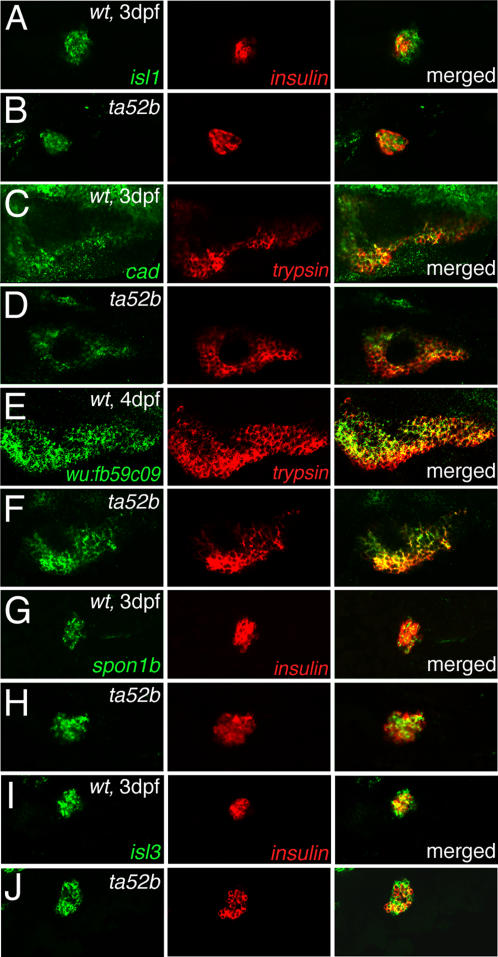
Validation of expression profile of differentially expressed genes with fluorescent double in situ hybridization.Expression of down-regulated genes: (A and B) isl1, (C and D) cad and (E and F) wu:fb59c09 and up-regulated genes: (G and H) spon1b and (I and J) isl3 in (B, D, F, H and J) mibta52b mutants embryos and (A, C, E, G and I) wild-type embryos. Left panels show respective gene expression in green; middle panels show insulin (endocrine) or trypsin (exocrine) expression in red; right panels show merged pictures. Expression of wu:fb59c09 is shown in 4-dpf embryos, and the rest are in 3-dpf embryos. All embryos are anterior to the left and ventral views.